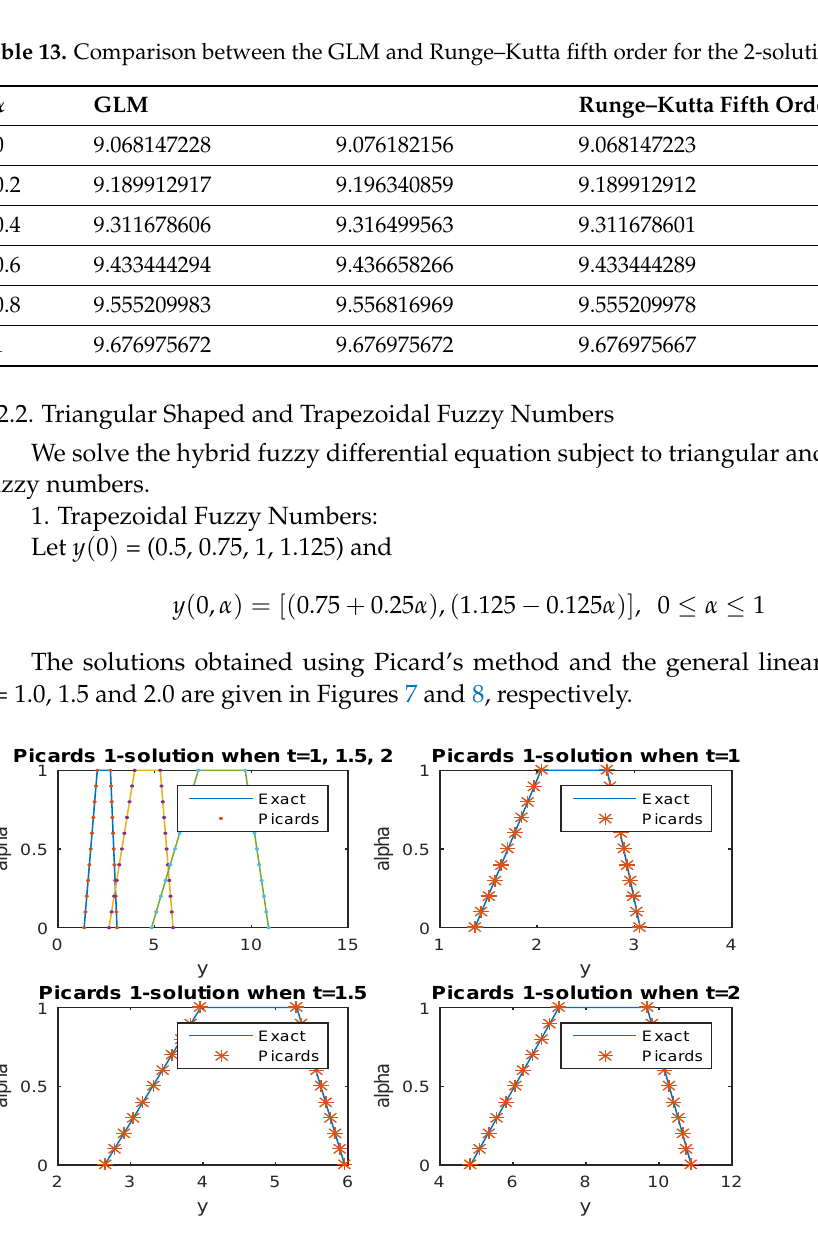
Figure 7. Exact(line) and Picard’s 1-solutions(stars) when t = 1.0, 1.5 and 2.0 with trapezoidal fuzzy numbers as the initial